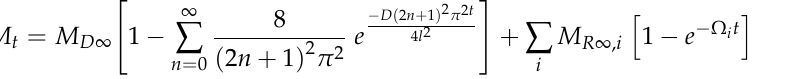
Table 5. Cu tt ing fl uid uptake properties.